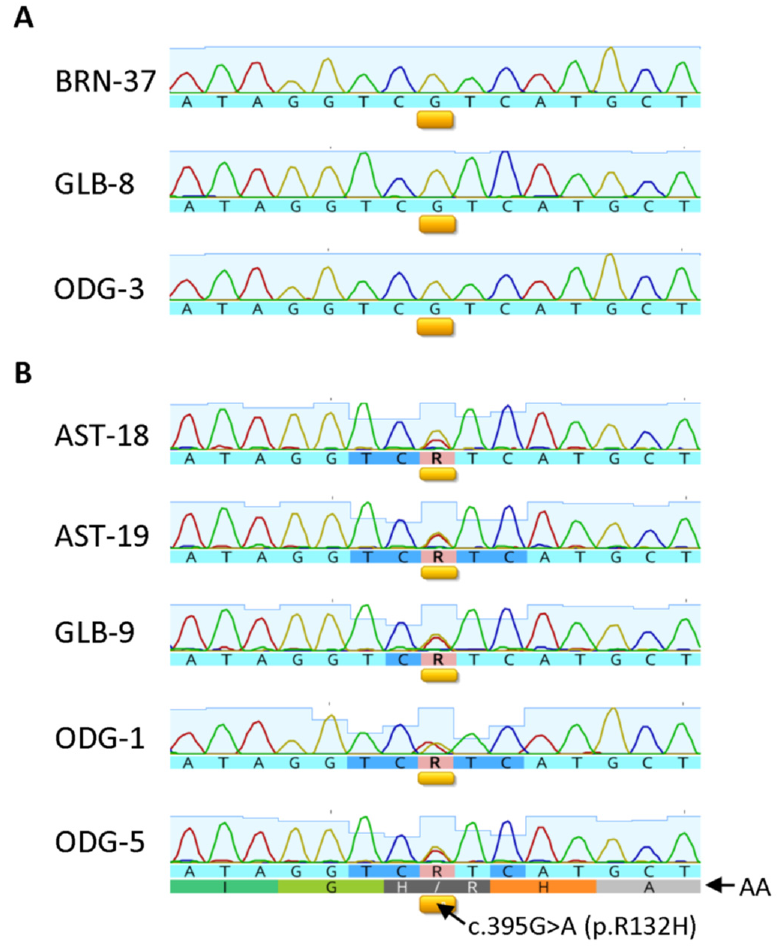
Figure 9. Sanger sequence chromatograms for three representative tissue samples that do not have the R132H mutation ( A ) and five tissue samples confirmed to have the R132H mutation ( B ). Corresponding amino acid sequences are labeled as AA. The c.395G > A (p.R132H) mutation location is underlined with yellow bars and labeled respectively. The presence of double chromatogram peaks corresponding to both guanine and adenine at nucleotide position c.395 indicates the presence of the c.395G > A (p.R132H) mutation and is annotated in the nucleotide sequences by the IUPAC nucleotide code R, whereas non-mutant tissue samples are identified by the presence of a single guanine peak at nucleotide position c.395 annotated in the nucleotide sequences by the code G.